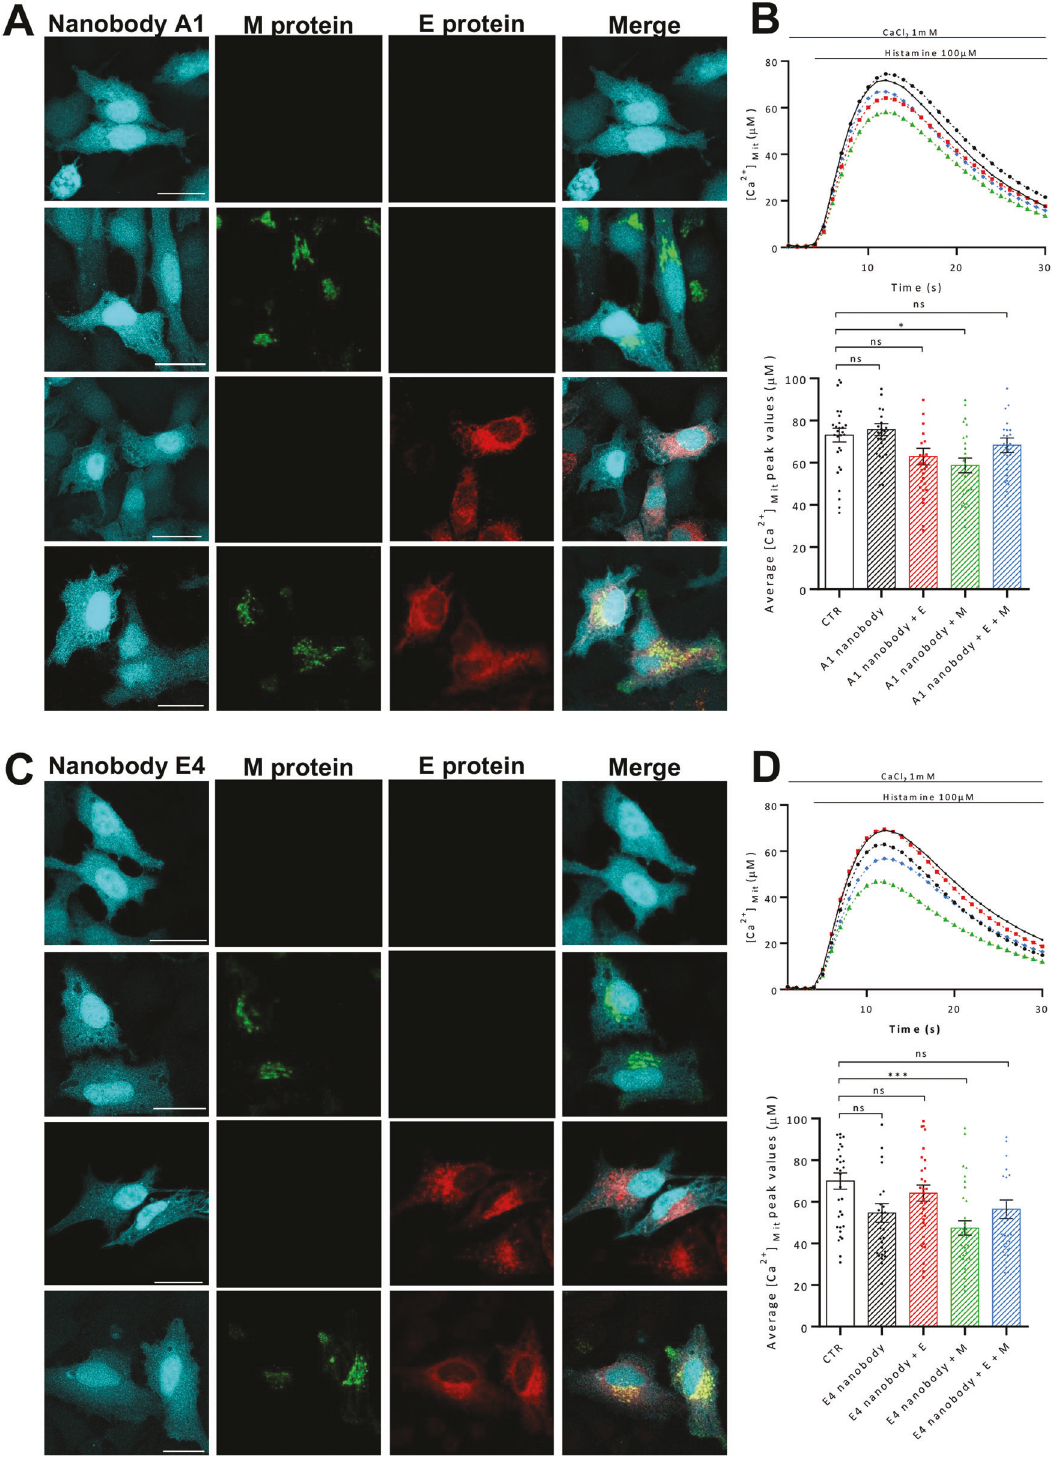
Fig. 5 The A1 and E4 nanobodies reverse the effect of the Sars-CoV-2 E protein on the host cell ’ s calcium handling. Representative images of HeLa cells expressing both the A1 ( A )/E4 ( C ) nanobody and the viral proteins/empty vector. The E and M proteins were detected with a rabbit polyclonal antibody anti-FLAG tag and a mouse monoclonal antibody anti-His tag, respectively. The presence of the nanobody was revealed by the CFP. Images were acquired with a Leica SP5 confocal microscope with a HCX PL APO 100.0×1.40 OIL objective upon illumination with laser at the wavelength of 405 nm, 488 nm, and 594 nm. Scale bar = 25 μ M. To assess the effect of the A1 ( B ) and E4 ( D ) nanobody, HeLa cells were transfected with the E and M proteins, either alone or in co-transfection, the mitochondrial-targeted mutated aequorin, and the nanobody of interest. Then, cells were stimulated with 100 μ M histamine to induce the mitochondrial Ca 2 + uptake. From each calcium trace (in the upper panel the average of at least 25 independent measurements obtained from three independent transfections, mean ± SEM), the peak was calculated and plotted in the lower panel (mean ± SEM). One-way ANOVA = **** p < 0.0001. Tukey ’ s multiple comparisons test was applied for multiple comparisons (* p < 0.05; *** p < 0.001 versus CTR). Cell Death and Disease (2023)